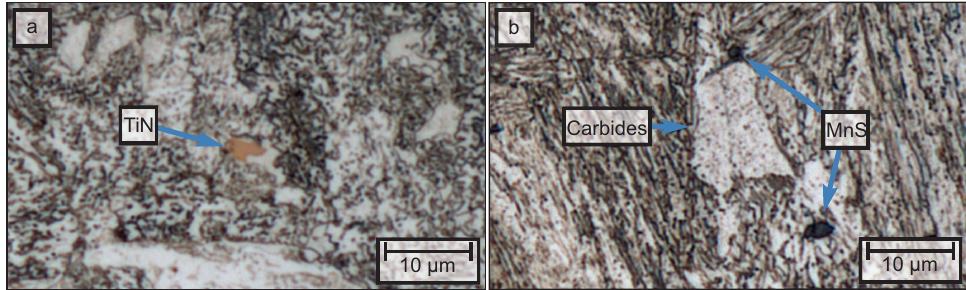
Figure 4. Precipitates observed by optical microscopy: ( a ) titanium nitride, ( b ) carbide agglomeration and manganese sulfides.